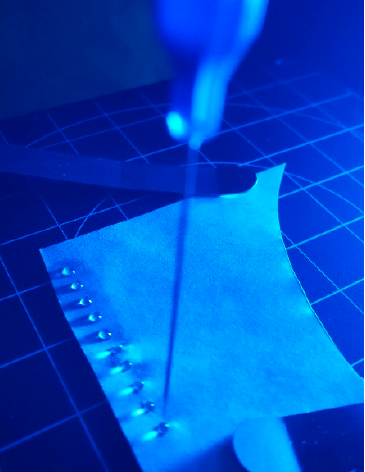
Figure 1. An array of distilled water and diiodomethane drops with a volume of 1.5 µL applied to the paper surface with a distance of 3 mm between individual drops.